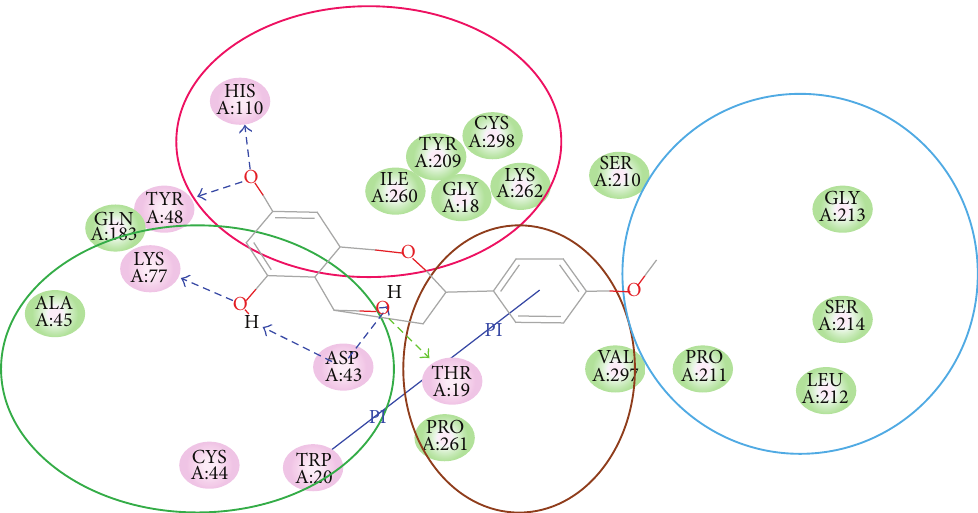
Figure9:2Ddiagramrepresentingtheorientationofpharmacophoremodelderivedfromacacetin-ALR2complexwithgreenspheres(HBA), magenta spheres (HBD), brown spheres (RA and PI), and cyan sphere (HY) interaction, the key residues in the